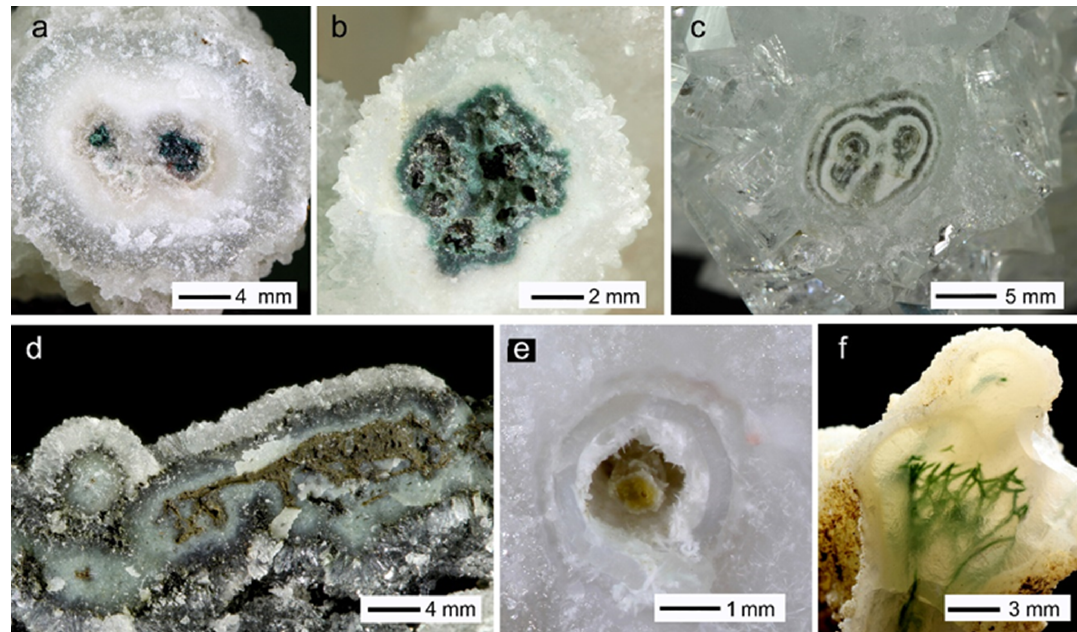
Figure 6. Cross-sections of SFF representing different structures: ( a ) Two separate core zones overgrown by silica, amalgamated to one SFF Ir . ( b ) Several directly connected core zones, overgrown by silica. ( c ) Two separate core zones surrounded by clay minerals and alternating silica layers. ( d ) Several separate and connected core zones overgrown by silica and enclosed clay minerals. ( e ) One core zone surrounded by an empty space, zeolite, and finally silica. ( f ) Several core zones overgrown by silica forming a tabular matted sheet SFF Ma .